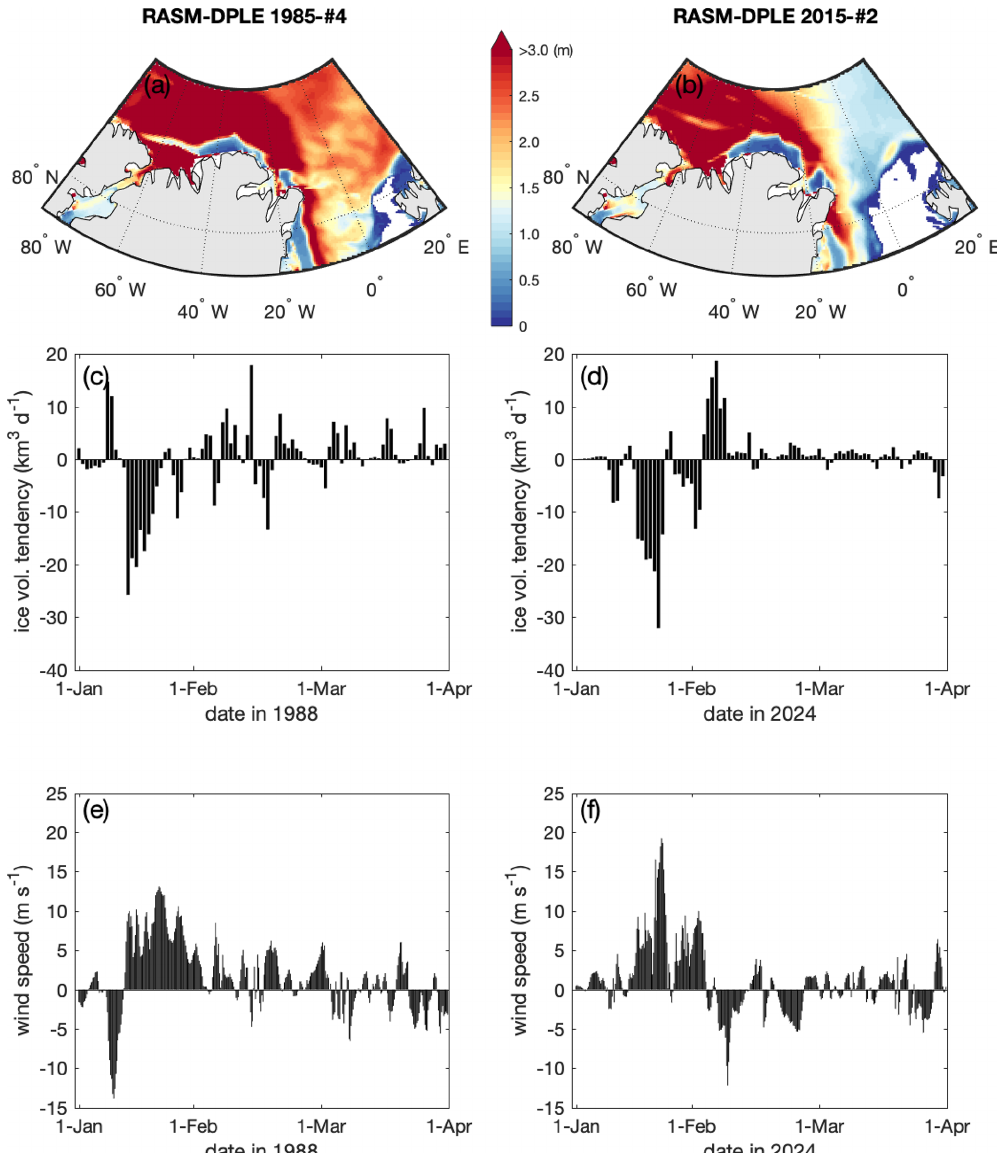
Figure 10. Sea ice thickness (SIT;m), sea ice dynamic volume tendency (DVT; km 3 d − 1 ) for the northern Greenland region (see Fig. 4a), and north (positive)–south (negative) wind component (ms − 1 ) during winter months from the ensemble member no. 4 in the 1985-initialized run and the ensemble member no. 2 in the 2015-initialized run: SIT on (a) 22 January 1988 and (b) 14 January 2024, daily DVT in January–March of (c) 1988 and (d) 2024, and 6-hourly north–south wind in January–March of (e) 1988 and (f)